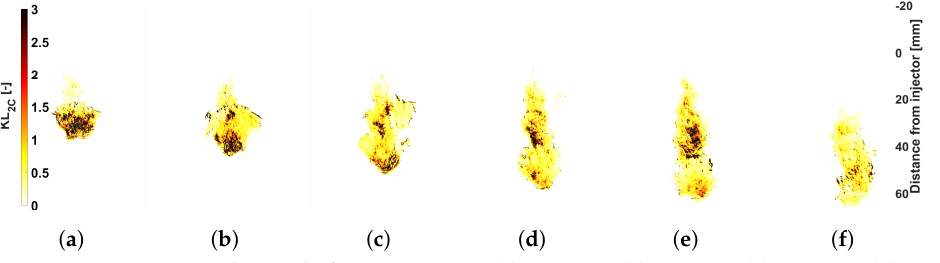
Figure 8. KL 2 C maps obtained after processing. ( a ) 1500 µ s. ( b ) 1850 µ s. ( c ) 2200 µ s. ( d ) 2550 µ s. ( e ) 2900 µ s. ( f ) 3250 µ s.